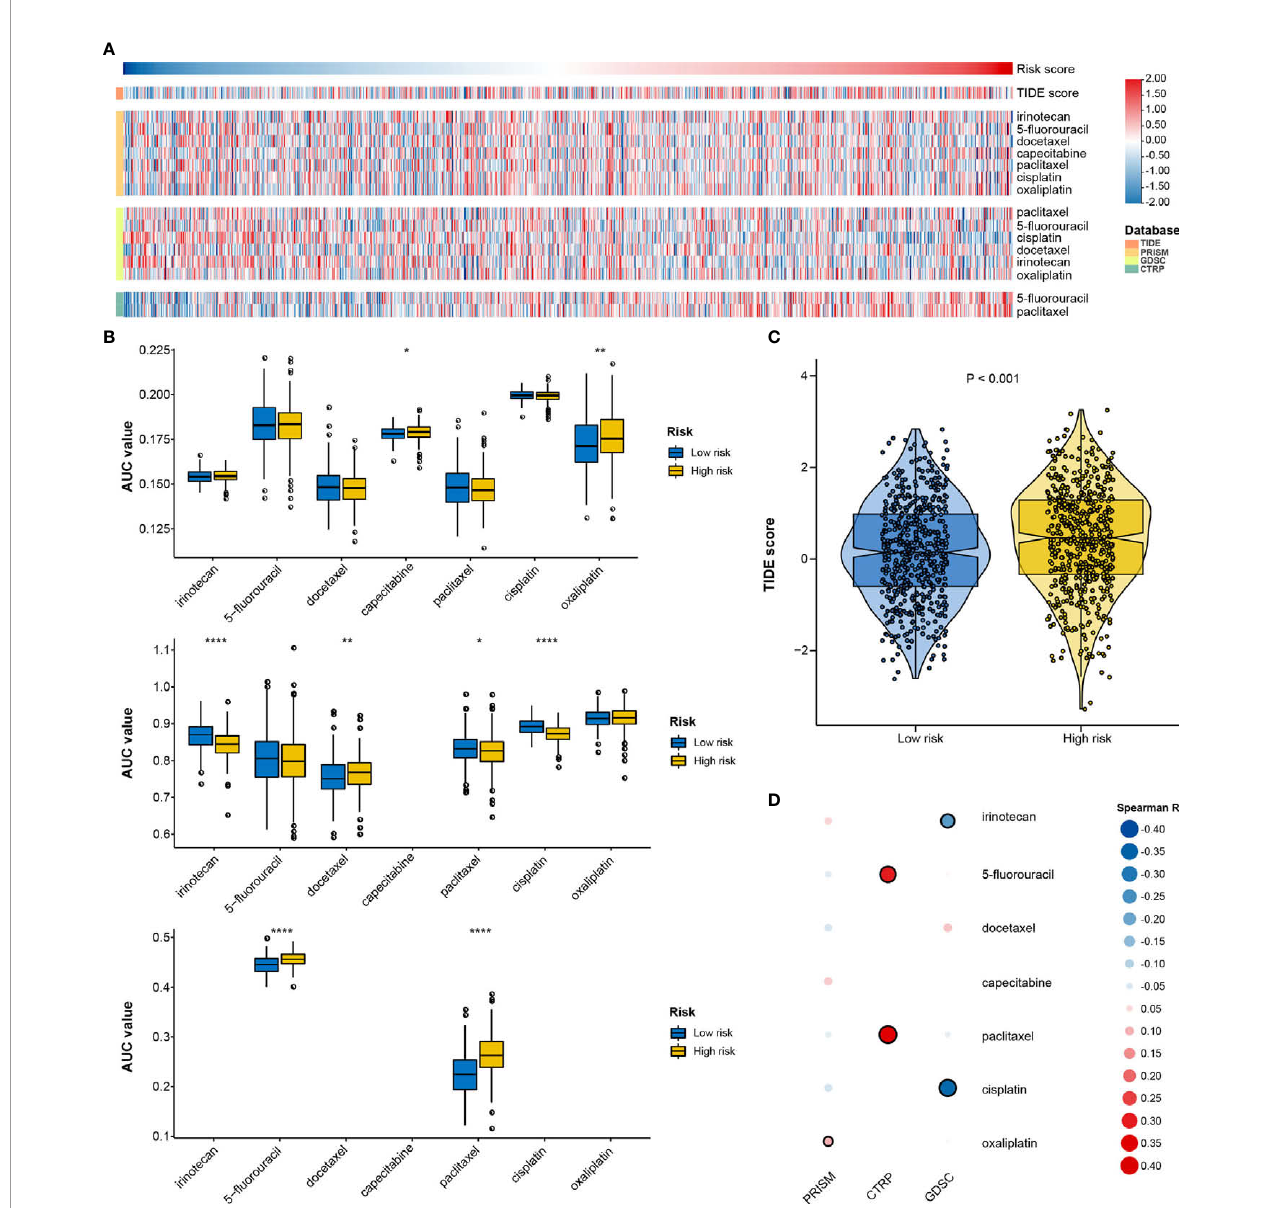
FIGURE 9 | Identi fi cation of drug response features underlying the RNA processing-related signature. (A) Heatmap showing the TIDE scores and AUC values for patients with GC with different risk scores. (B) Differential analysis of the selected chemotherapeutic agents for patients with GC with higher and lower risk scores in the PRISM, CTRP, and GDSC databases. P values were obtained by the Mann-Whitney test. The asterisks represented the statistical P-value (*P < 0.05; **P < 0.01; ****P < 0.001). (C) Violin plots of TIDE scores for patients with GC in the high-risk and low-risk groups. (D) Heatmap showing the Spearman correlation coef fi cient between the AUC values and the risk scores for the selected chemotherapeutic